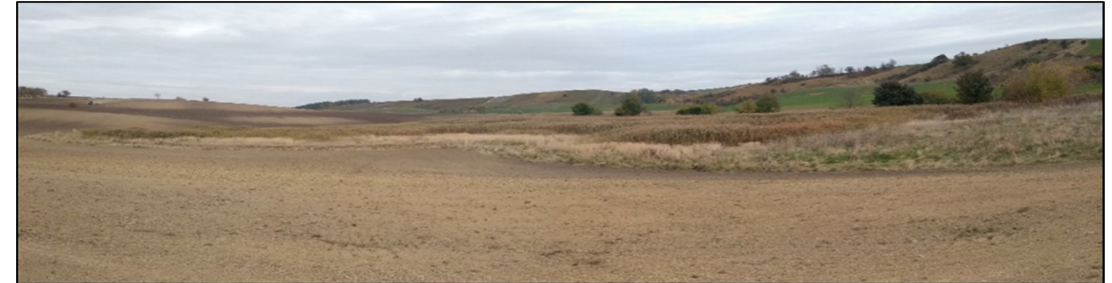
Figure 2. Panoramic view of hygrophilous vegetation on the site of the defunct Helesné (Šatrapský) pond, Čejkovice cadaster GPS (WGS84): 48.8719086N, 16.9257403E.